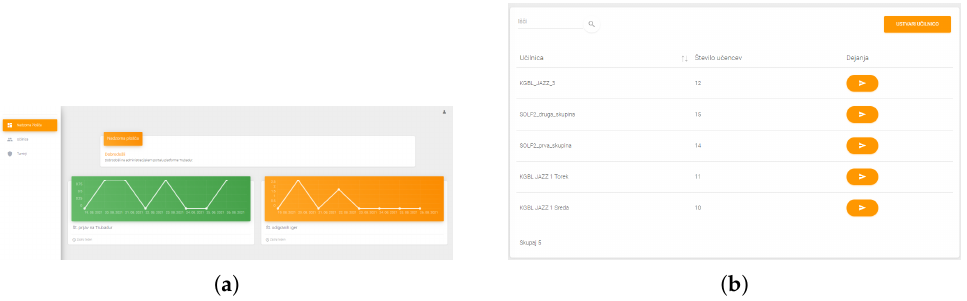
Figure 3. Learning management system within the platform. ( a ) Administration panel; ( b ) List of classrooms.